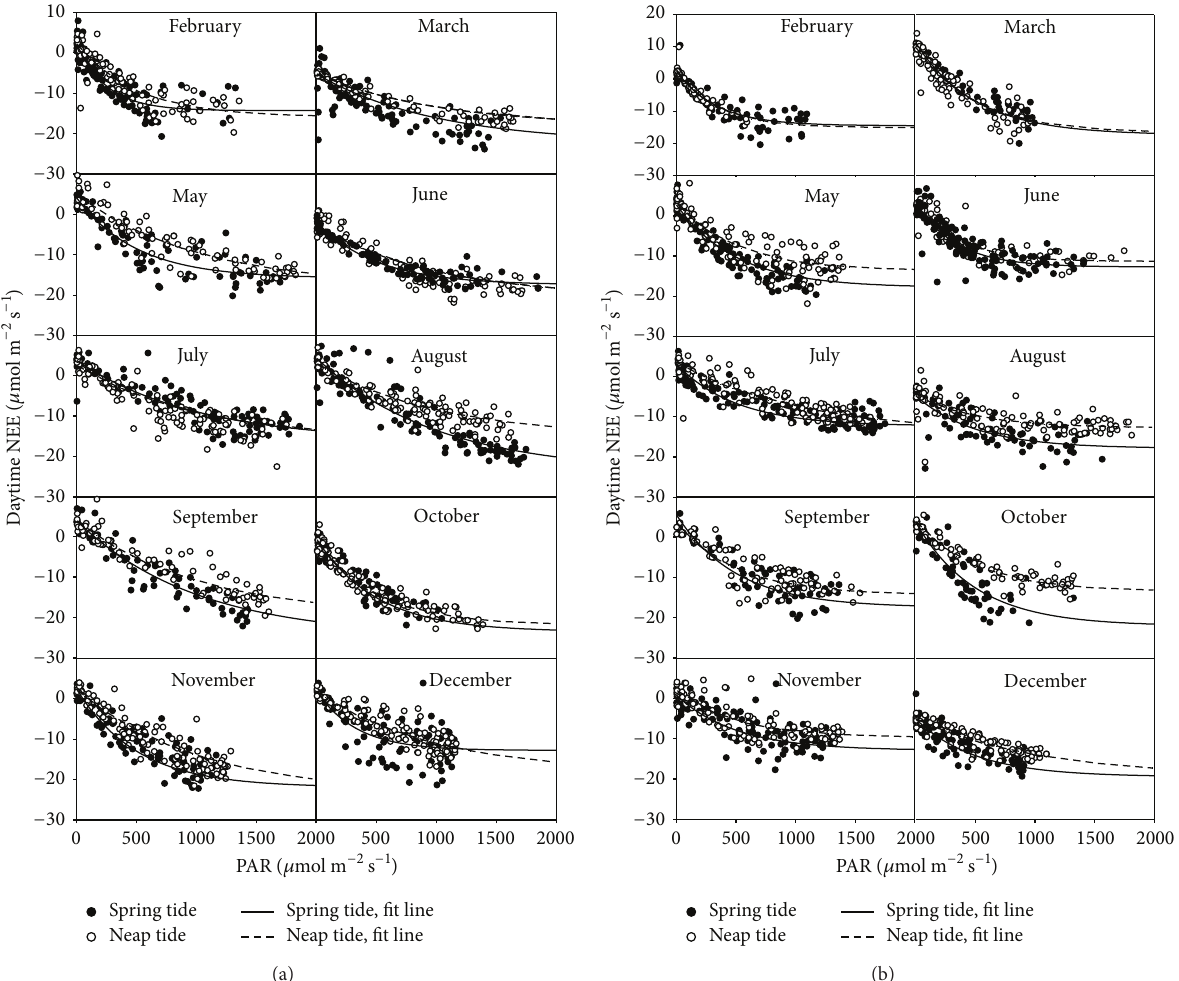
Figure 5: Daytime NEE versus PAR partitioned by spring tides and neap tides for the 10 selected months of the year 2010 ((a) FJZZ and (b) GDZJ). Fit (solid and dashed lines) curves from nonlinear regression analysis of daytime NEE versus PAR based on (2) (the Landsberg model) were